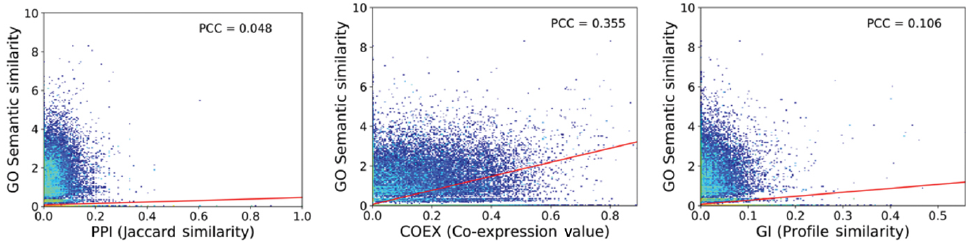
Figure 2: Correlations with GO. Correlations between molecular interaction and semantic similarity based gene similari- ties. COEX data (middle) best fits to GO with Pearson ’ s correlation coefficient (PCC) of 0.355, followed by GI data (right, with PCC of 0.106) and PPI data (left, with PCC of 0.048). The heat maps are based on the number of gene pairs in the corresponding region: yellow/green areas contain more gene pairs than blue areas; white areas contain no pairs.